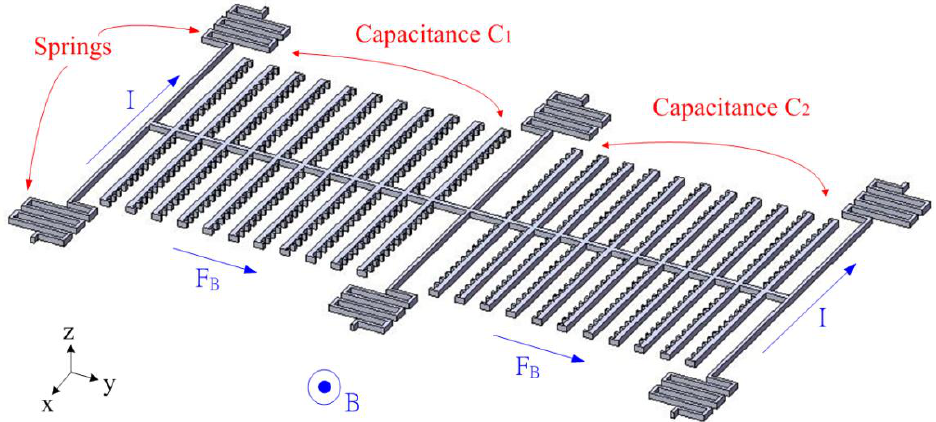
Figure 1. Schematic structure of the magnetic sensor, where I is current; B is magnet; F Lorentz